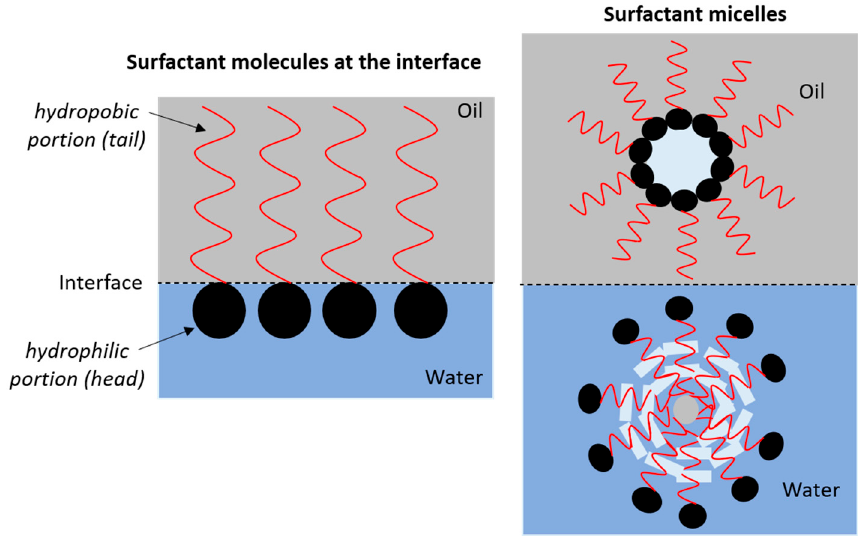
Figure 10 . Scheme of surfactant structure, behavior at the interface and micelles. Figure 10. Scheme of surfactant structure, behavior at the interface and